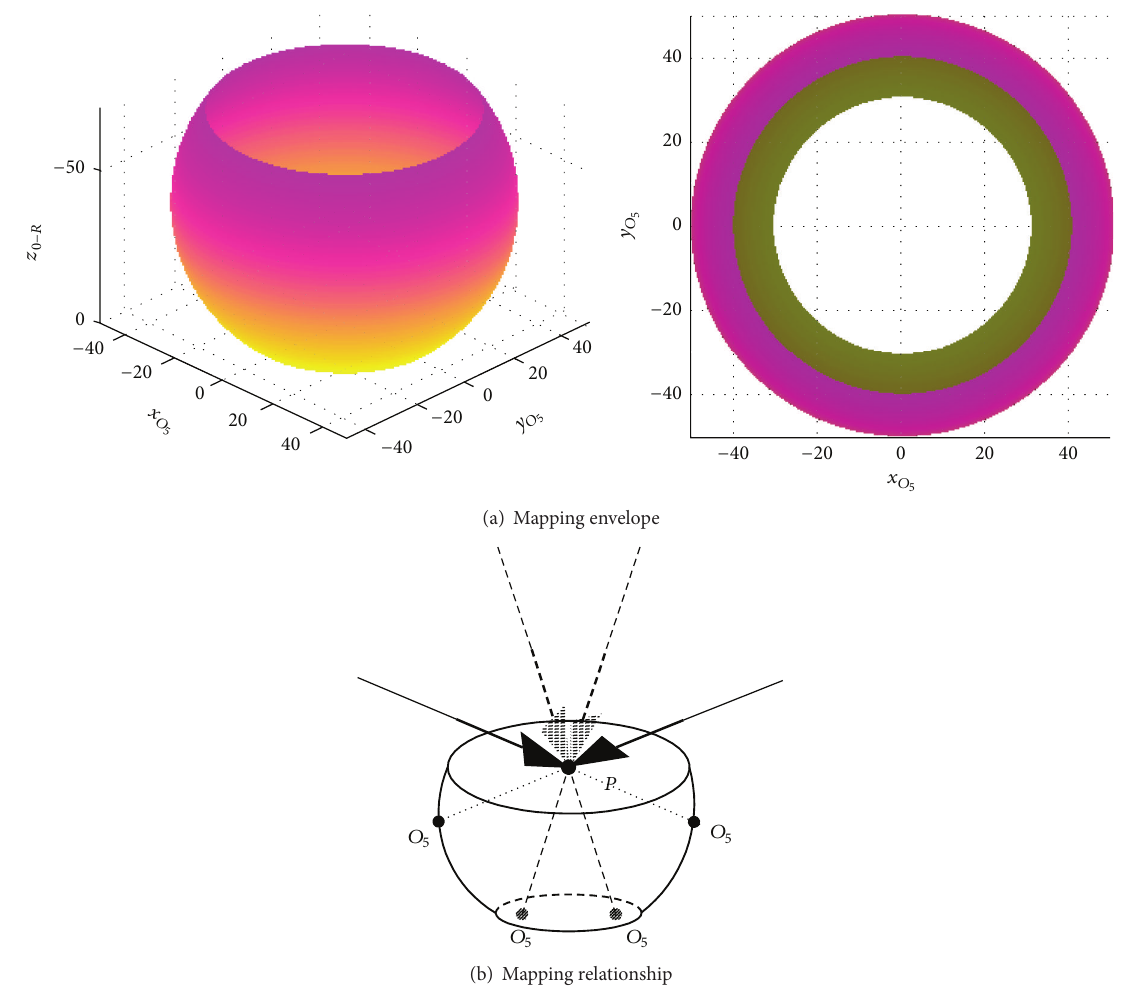
Figure 4: The example of 𝐿 𝑃 = −70 and 𝑒 = 30